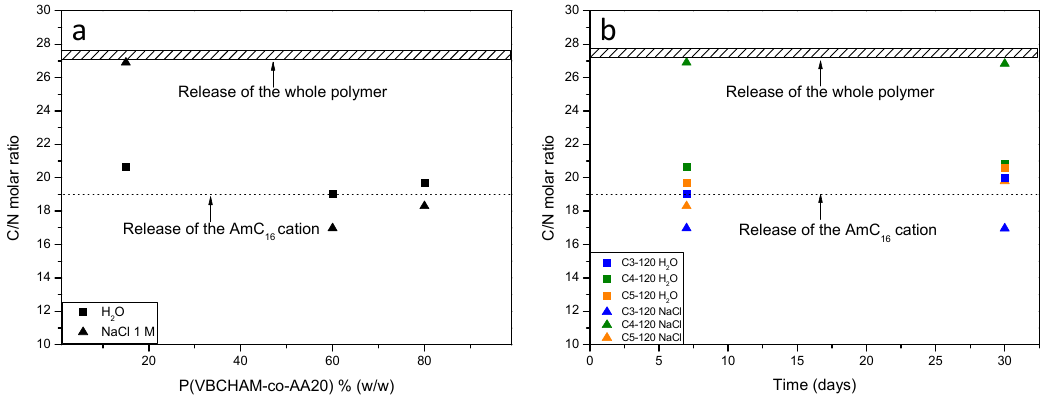
Figure 7. ( a ) Influence of the P(VBCHAM ‐ co ‐ AA20) % ( w / w ) content of the cured P(SSAmC 16 ‐ co ‐ GMA20)/P(VBCHAM ‐ co ‐ AA20) 40/60 w / w polymeric coatings on the C/N molar ratio determined from the TOC and TN values of the solutions after immersion of the coatings for seven days in ultra-pure water and aqueous NaCl 1 M solutions, ( b ) Evolution of the C/N molar ratio, determined from the TOC/TN studies, after immersion in ultra-pure water and NaCl 1 M for different time periods of cured C3-120, C4-120, C5-120 polymeric coatings.